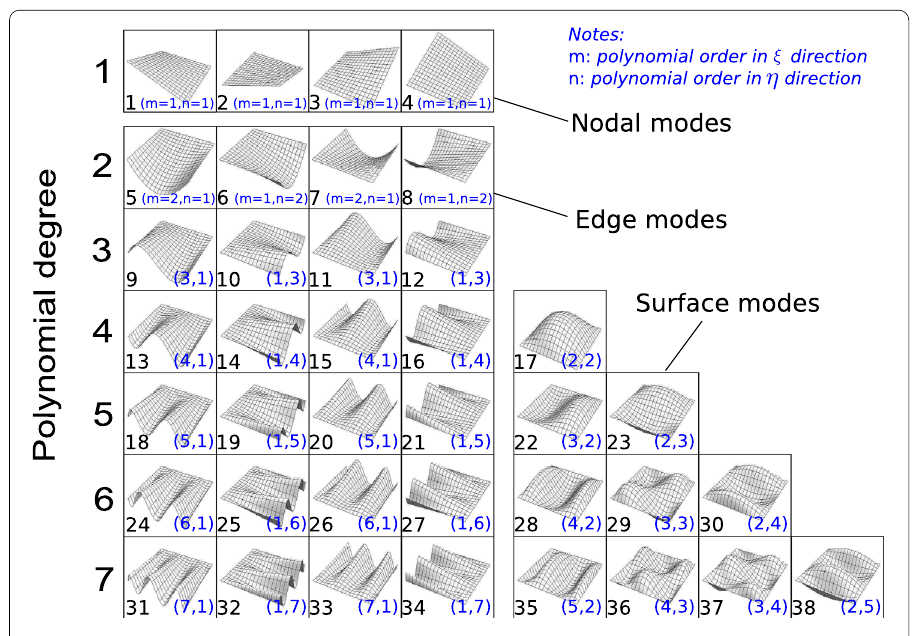
Full integration